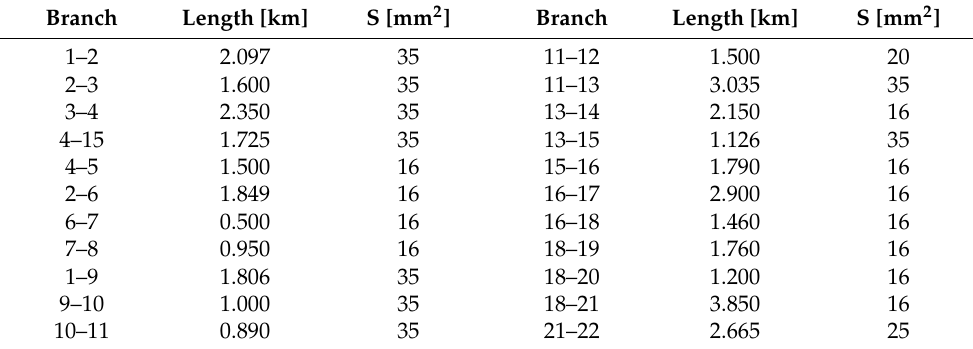
Table 2. Network branch data.